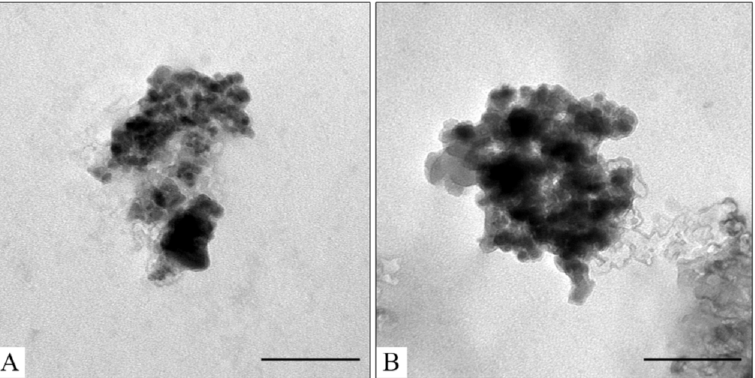
Figure 10. TEM images of Fe 3 O 4 @CaCO 3 /DOX525-HSA3.2 ( A ) and Fe 3 O 4 @CaCO 3 /DOX525-HSA32 ( B ). The bar indicates 100 nm.